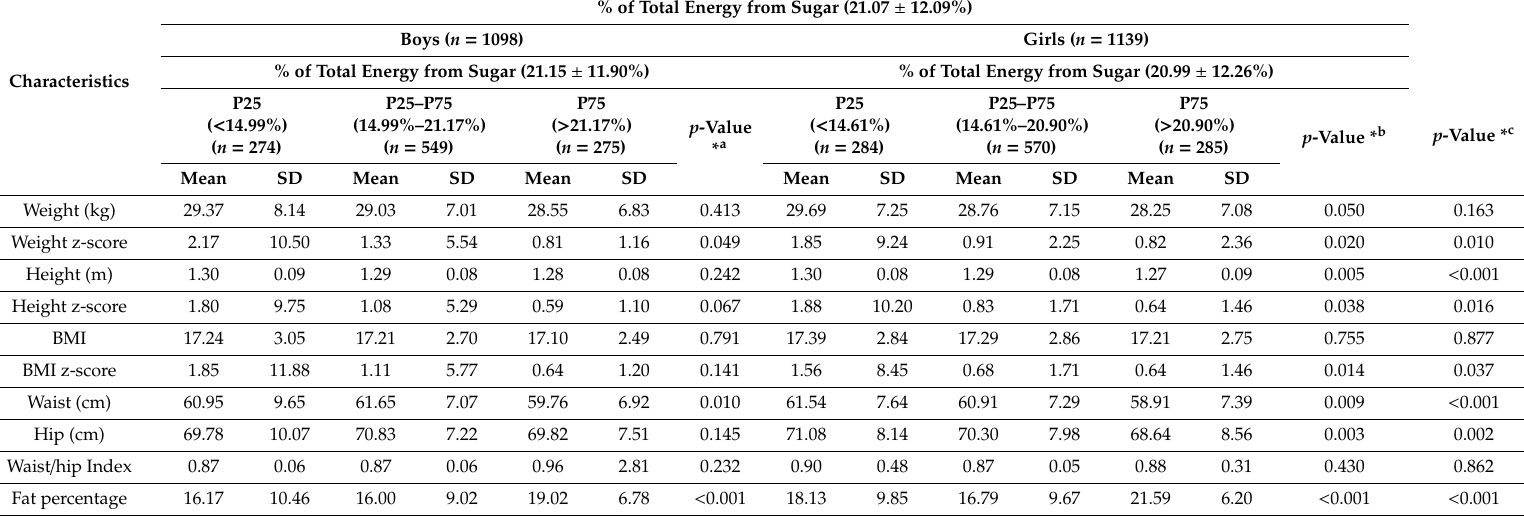
Table 6. Anthropometric characteristics of schoolchildren in relation to % of total energy intake from sugar intake consumed by 6–8 years old children ( n = 2237) in Valencia, Spain,